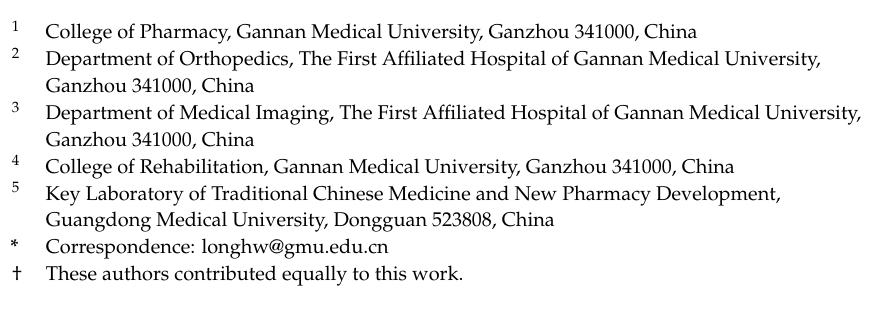
Figure 1 should be changed